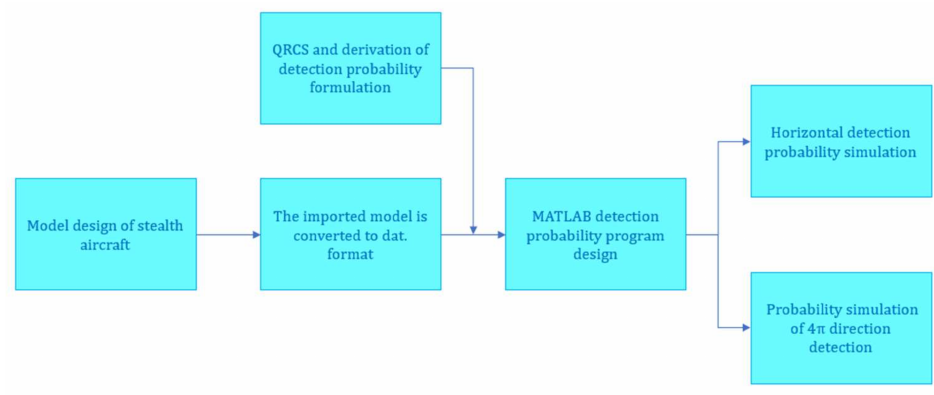
Figure 15. Simulation process.